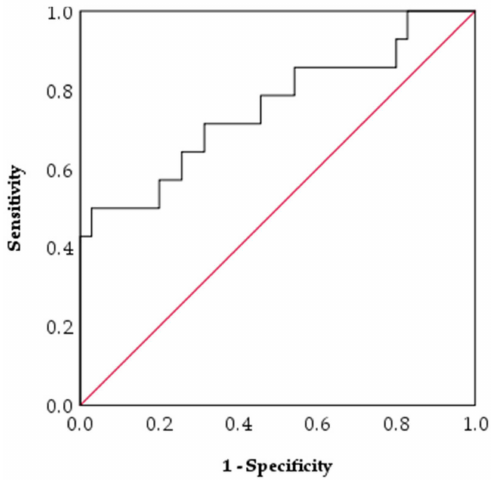
Figure 2. Receiver operating characteristic (ROC) curve analysis of baseline serum HE4 for distinguishing non-responders from responders to the LNG-IUS in AH / Stage 1a EEC (AUC = 0.755 ± 0.084, 95% CI 0.590–0.921, p = 0.006, n =